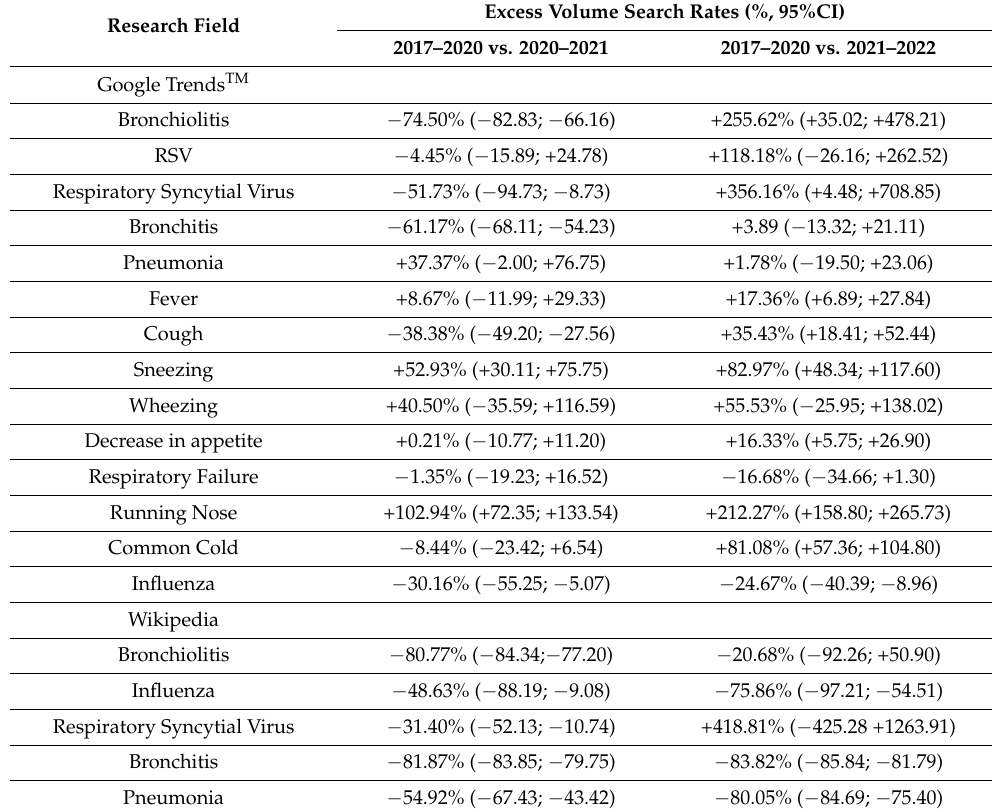
Table 5. Excess volume searches for research terms in Google Trends and in Wikipedia (Italy). In the analyses, average estimates for 2017–2019 were assumed as the reference categories.